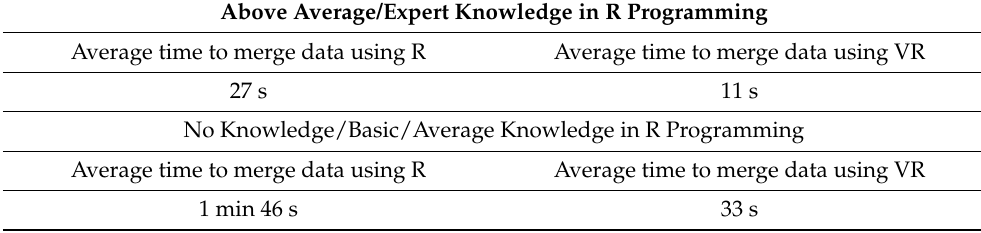
Table 8. Average time to merge data in R and VR: A